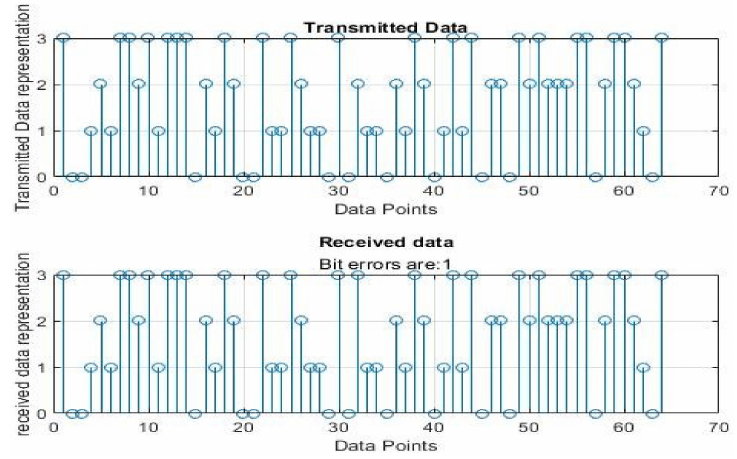
Figure 10. GAWDO QPSK output for 64 data points in a noisy channel.